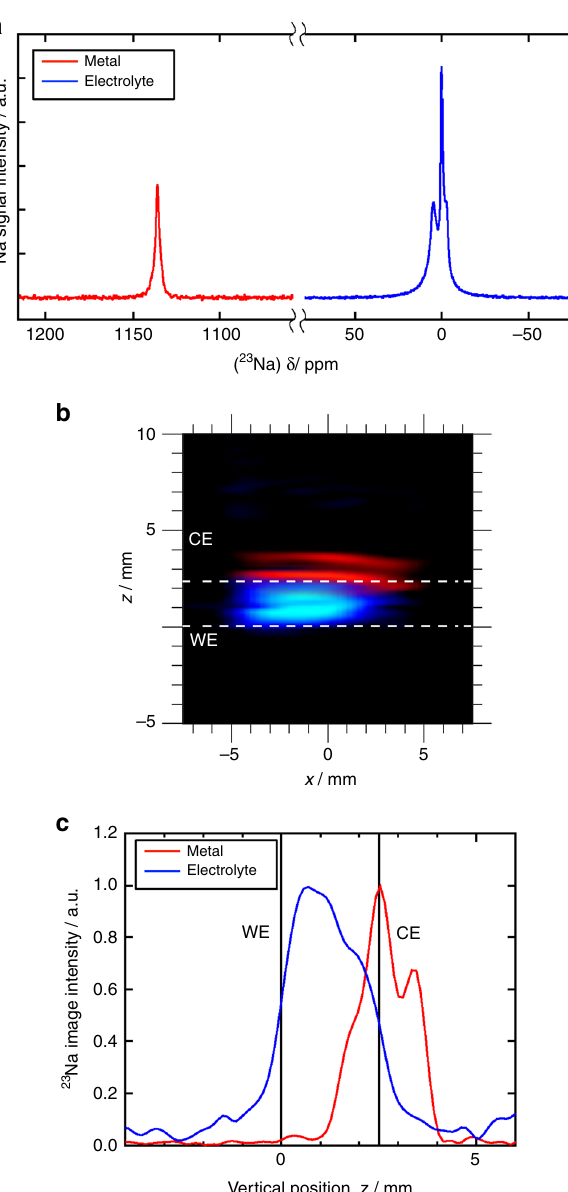
Fig. 2 23 Na NMR signal after a single charge/discharge (30 mA g − 1 ) cycle. a 23 Na NMR spectra for solvated Na in the electrolyte (blue spectrum) and for metallic Na (red spectrum). b 2D 23 Na MRI of metallic (red) and dielectric (blue) sodium in the cell. c 1D 23 Na MR pro fi le of sodium in metallic and electrolytic environments in the cell. This is cell was assembled with two